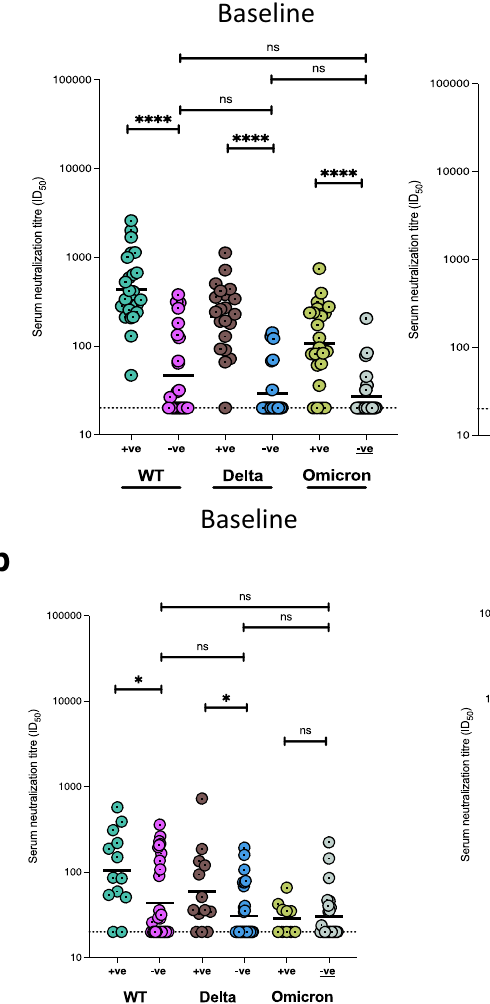
Fig. 3 | Longitudinal SARS-CoV-2 neutralization by sera from AZD1222 vaccinated individuals in two west African countries strati fi ed by N antibody statusatbaseline.a Neutralisationtitresbeforeandaftervaccine( n =49)strati fi ed by N antibodies at baseline in Nigerian participants. b Neutralisation titres before and after vaccine ( n =45) strati fi ed by N antibodies at baseline in Ghanaian